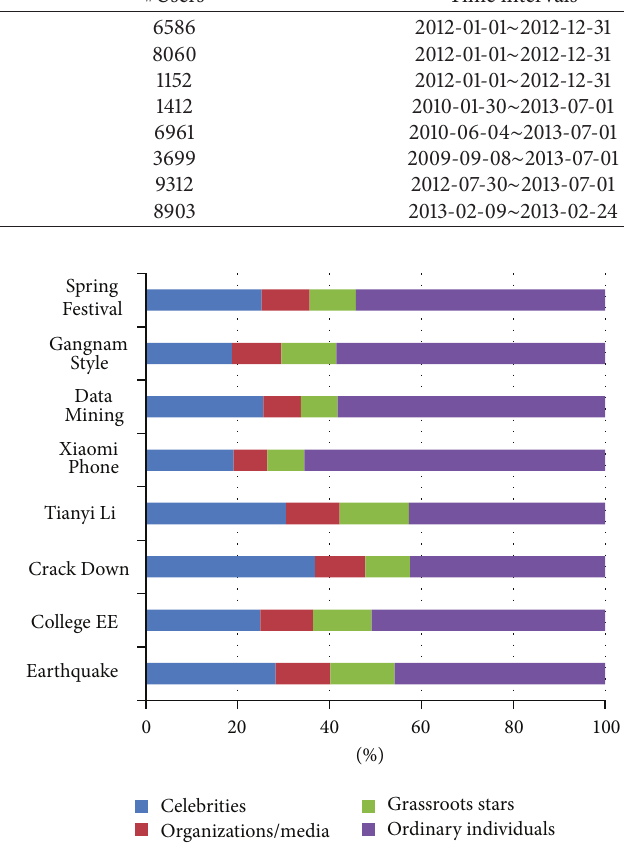
Figure 2: User size distribution on each event.